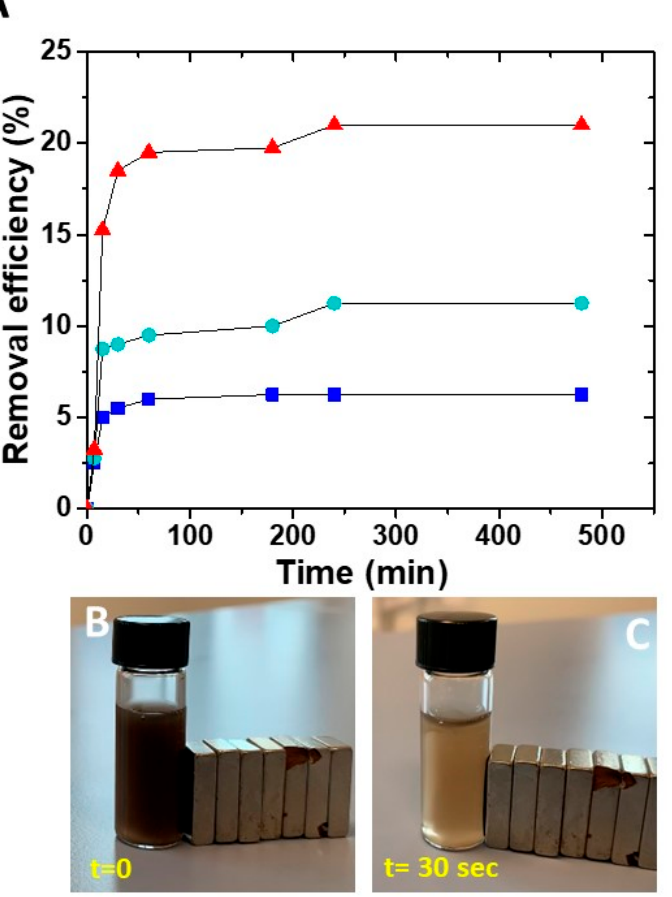
Figure 7. Time course of removal efficiency (%) of Cu 2+ by SPION@PDA NPs at different concentrations: 0.2 mg/mL (blue line), 0.4 mg/mL (green line), 0.8 mg/mL (red line) ( A ). SPION@PDA NP solution at beginning of the experiment (t = 0) ( B ) and 30 s after ( C ) the application of an external magnetic field.